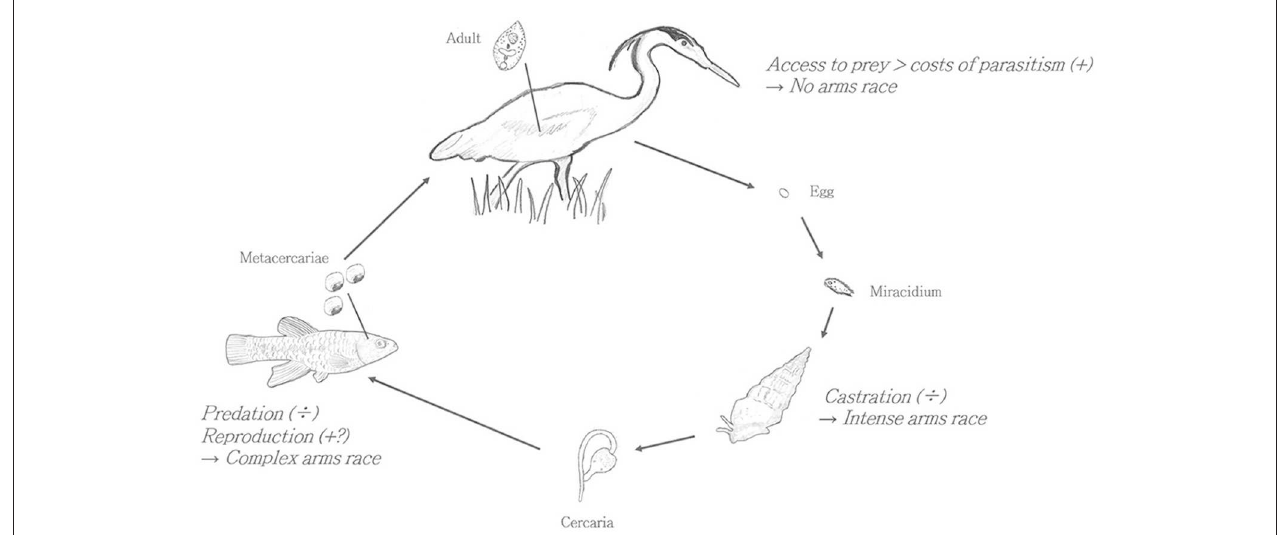
FIGURE 1 | Hypothesis: Whether a parasite is beneficial or adverse for any given host, and thus the direction of immune systems evolution, depends on host phenotype changes throughout the lifecycle. The Euhaplorchis Californiensis model system.